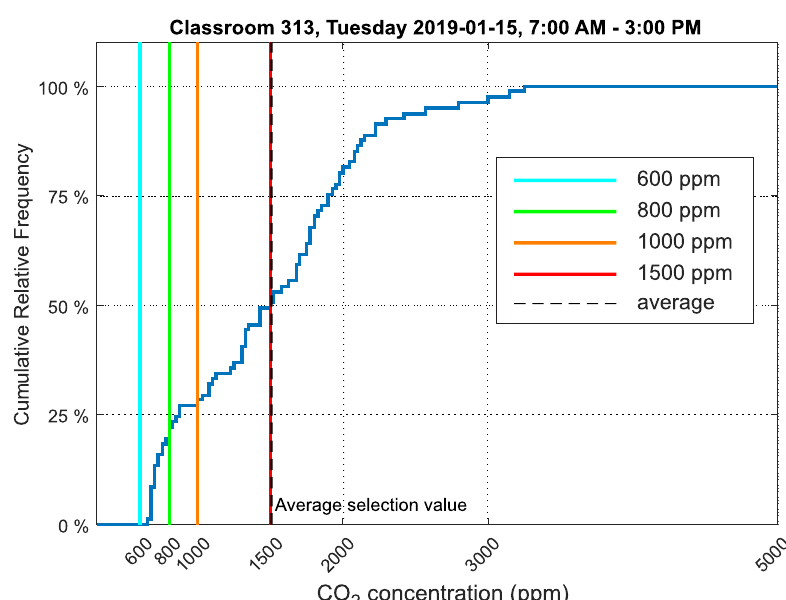
Figure 20. Cumulative frequency graph of the data selection showing CO 2 concentration in classroom 313, Frenštát pod Radhoštˇem.